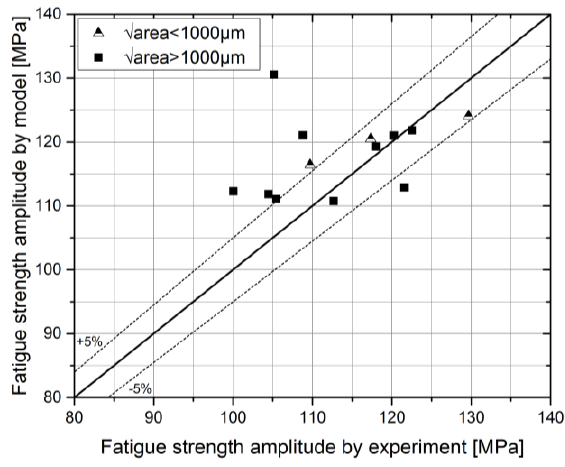
Figure 9. Comparison of fatigue strength amplitude by experiments to model by Murakami [33].